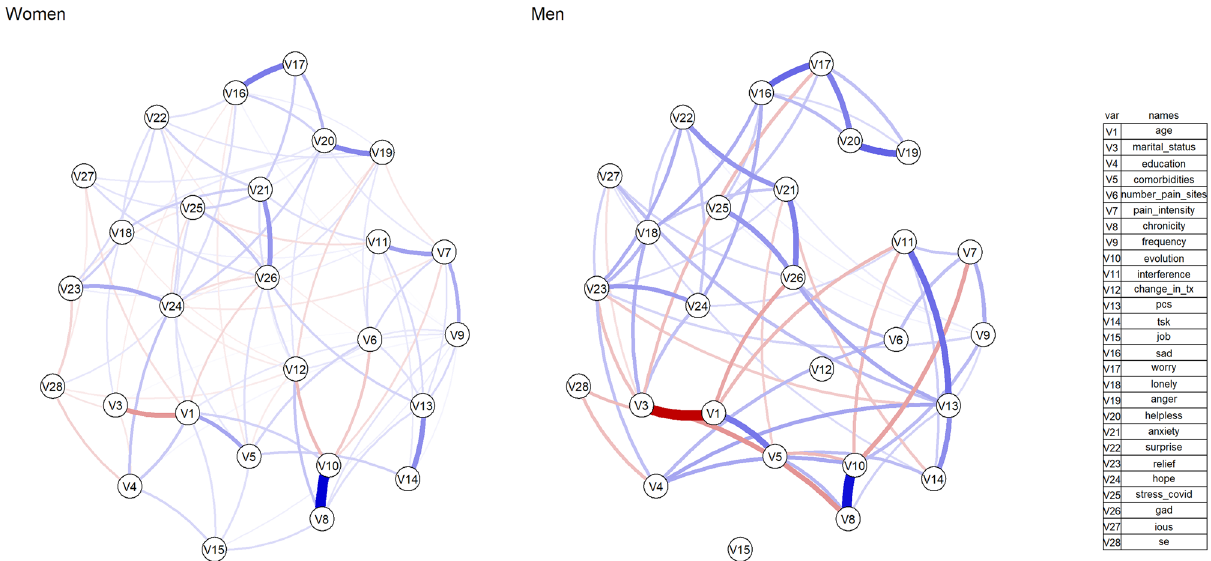
Figure 3. Subgroup network analysis for gender differences. Edges represent connections between two nodes and are interpreted as the existence of an association between two nodes, adjusted for all other nodes. Each edge in the network represents either positive regularized adjusted associations (blue edges) or negative regularized adjusted associations (red edges). The thickness and colour saturation of an edge denotes its weight (the strength of the association between two nodes).